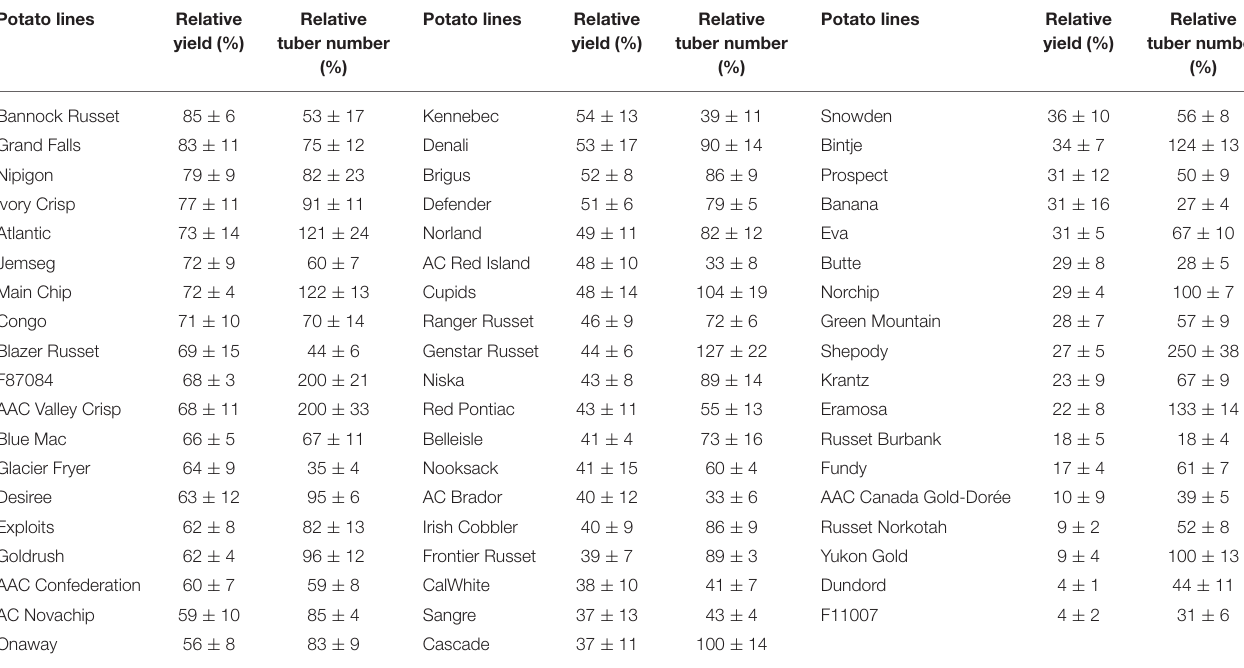
TABLE 1 | Relative tuber yield and number for drought-stressed plants relative to their well-watered controls (%). Potato